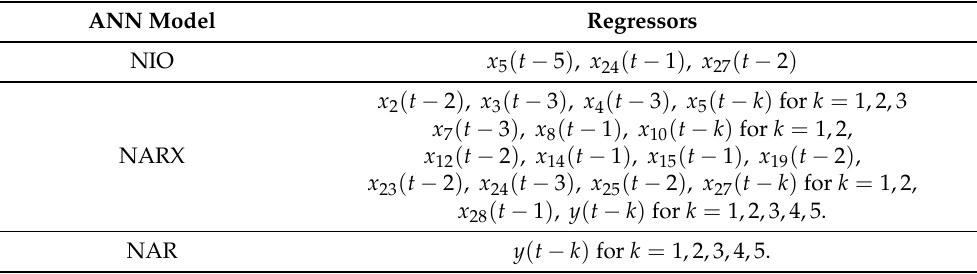
Table 2. Significant regressors in the input layers of neural